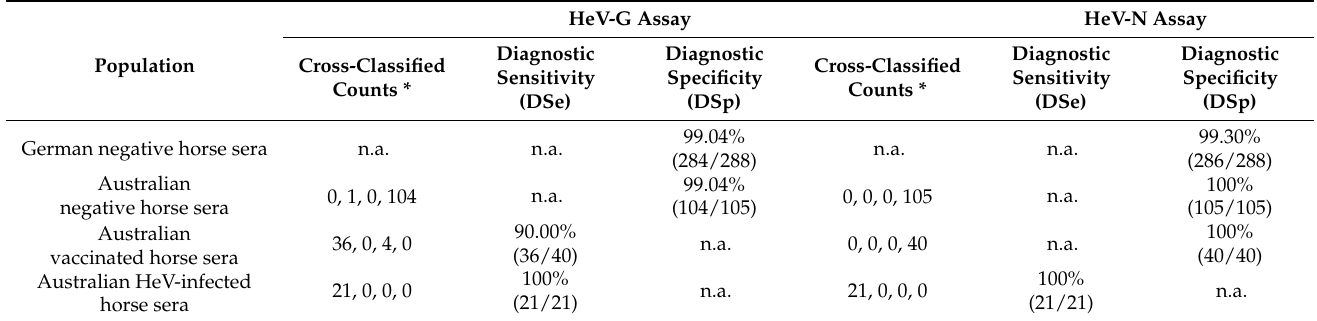
Table 2. Diagnostic performance of HeV G and HeV N at cut-off PP values of 40 and 43, respectively (frequentist approach). The number of horses positive in each population is given in brackets.